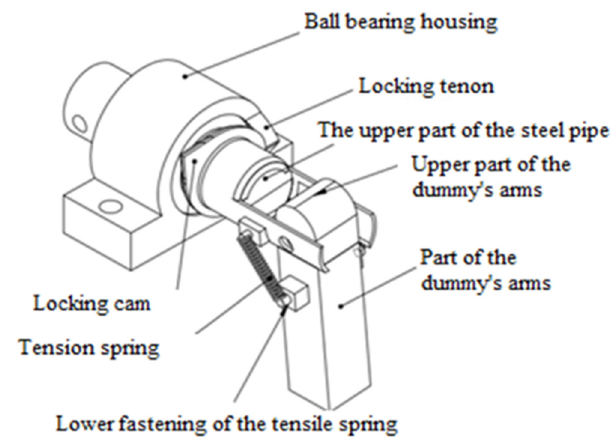
Figure 5. Construction of the shoulder joint of a crash test dummy.